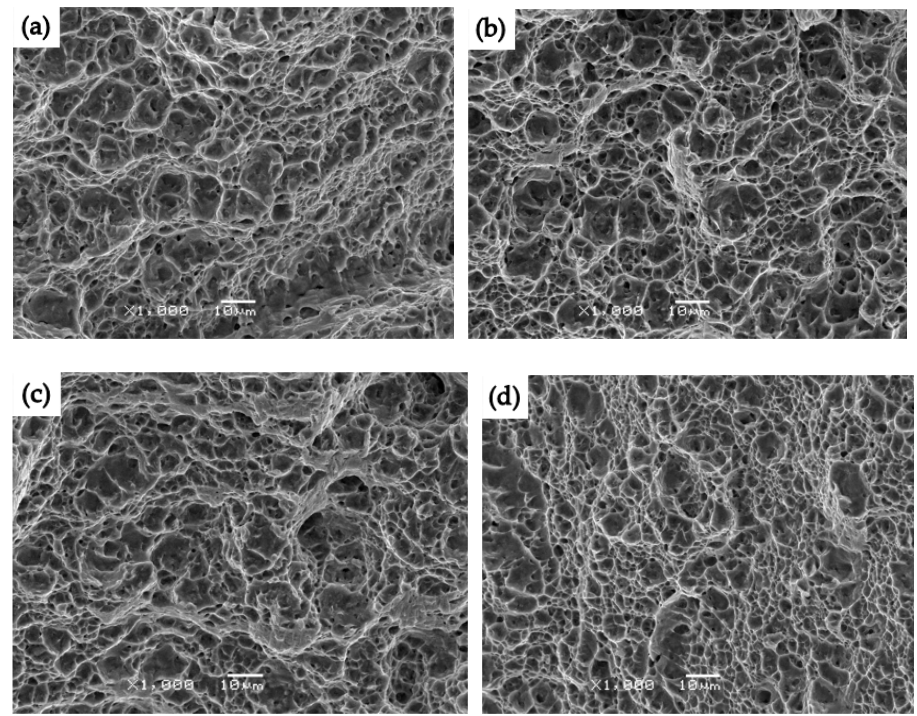
Figure 16. Engineering stress-strain curves of tensile specimens of hot press formed workpiece at 550 °C.